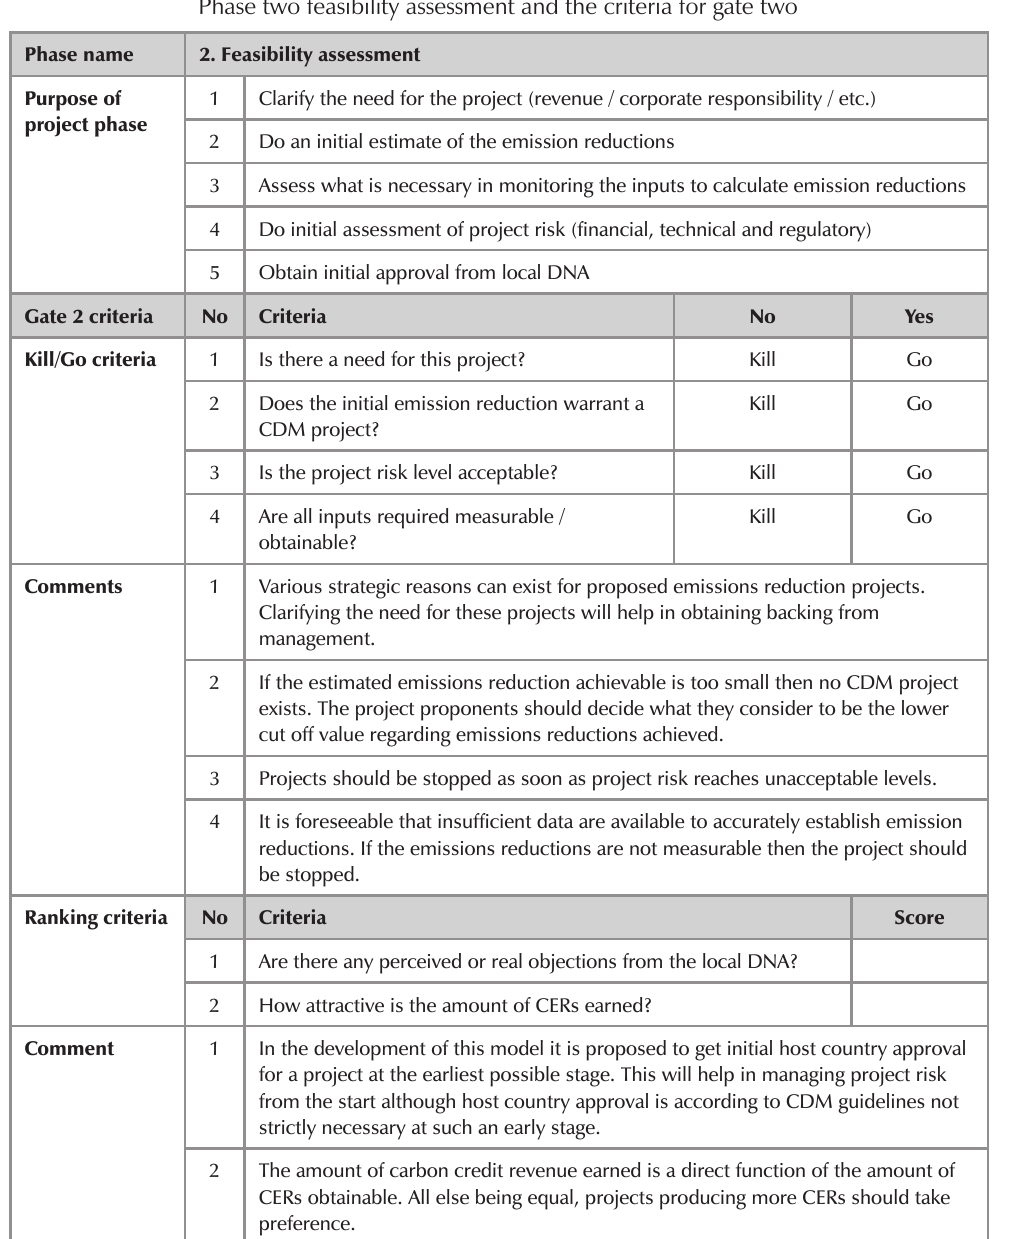
Phase two feasibility assessment and the criteria for gate